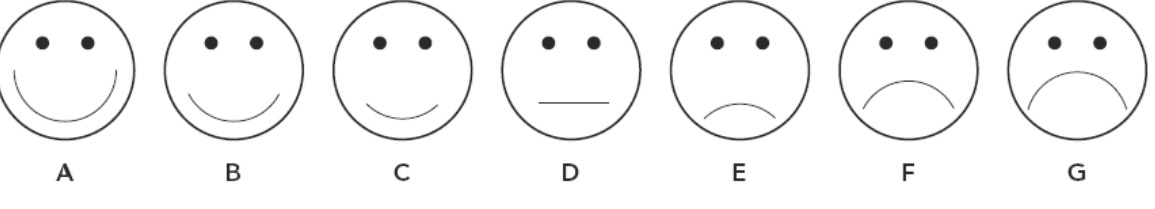
Figura 1 . Instrumento utilizado para determinação de autopercepção de felicidade (McDowell & Newell,